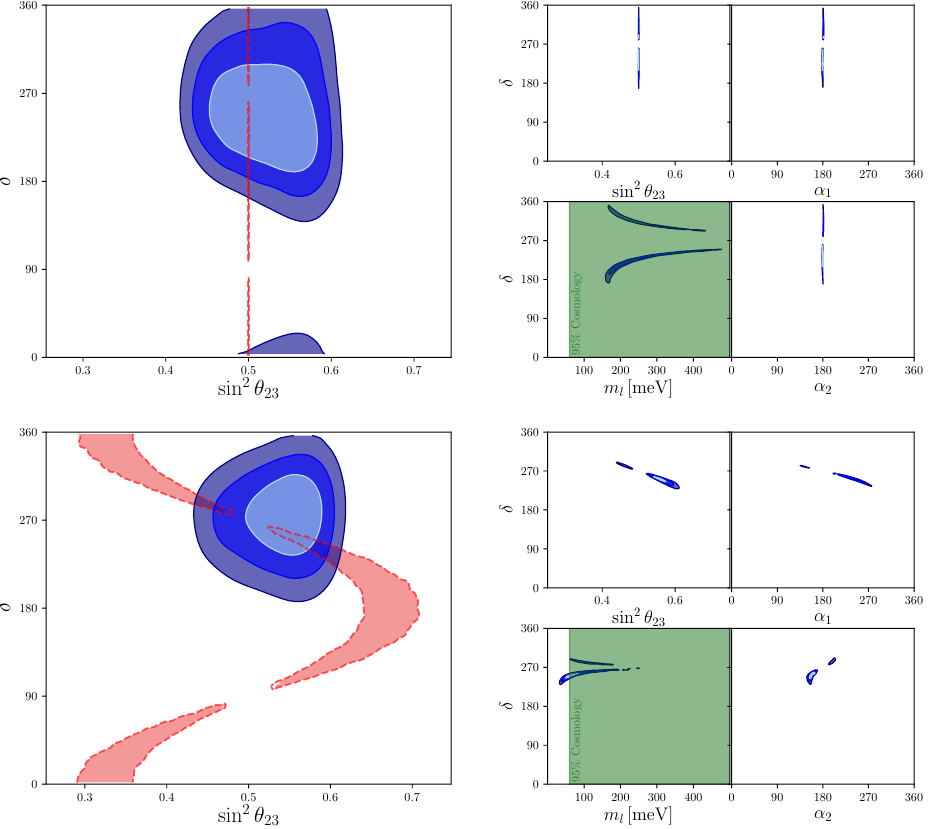
Figure 4 . Same as (cid:12)gure 2 for the C texture. In the upper panels for NO and the lower ones for